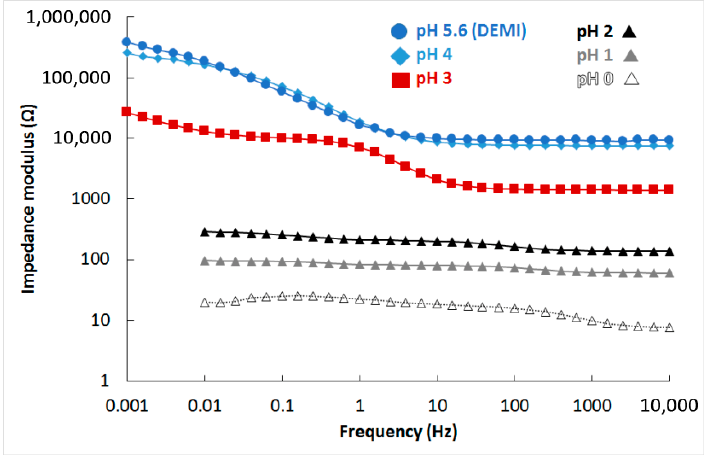
Figure 15. Bode plot (impedance modulus) in sulphuric acid solutions.